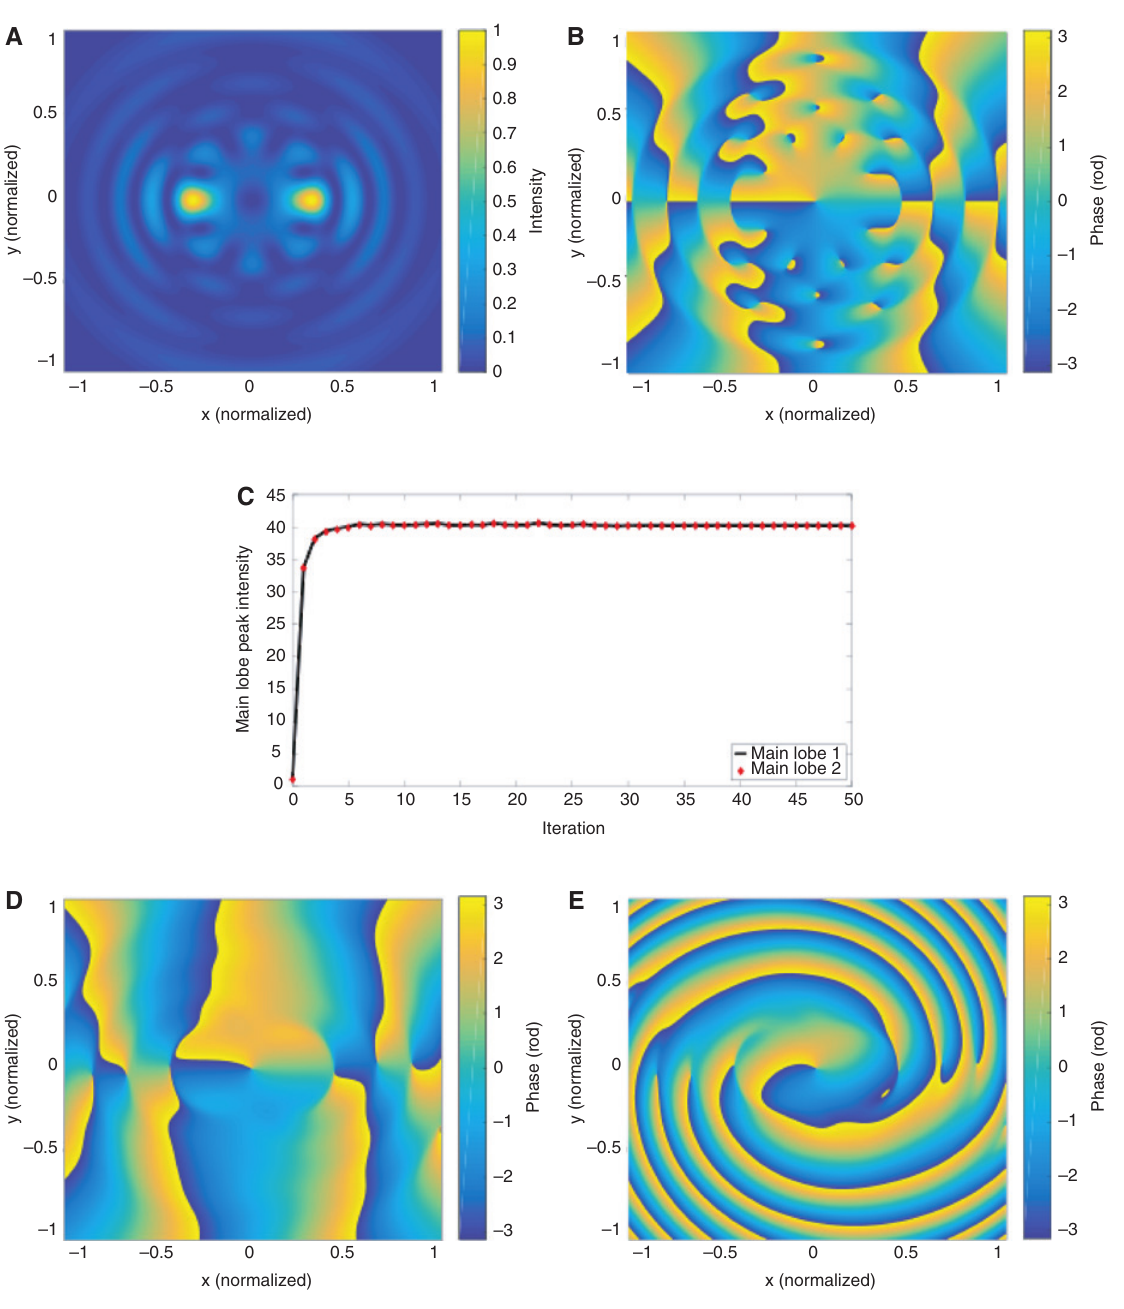
of this improved optimization approach can be found in s 1,2 the Supplementary material. , y ) and ( x , y ) are the a a b b The evolutions of peak intensities of the main lobes are shown in Figure 1C. The solid and dotted lines